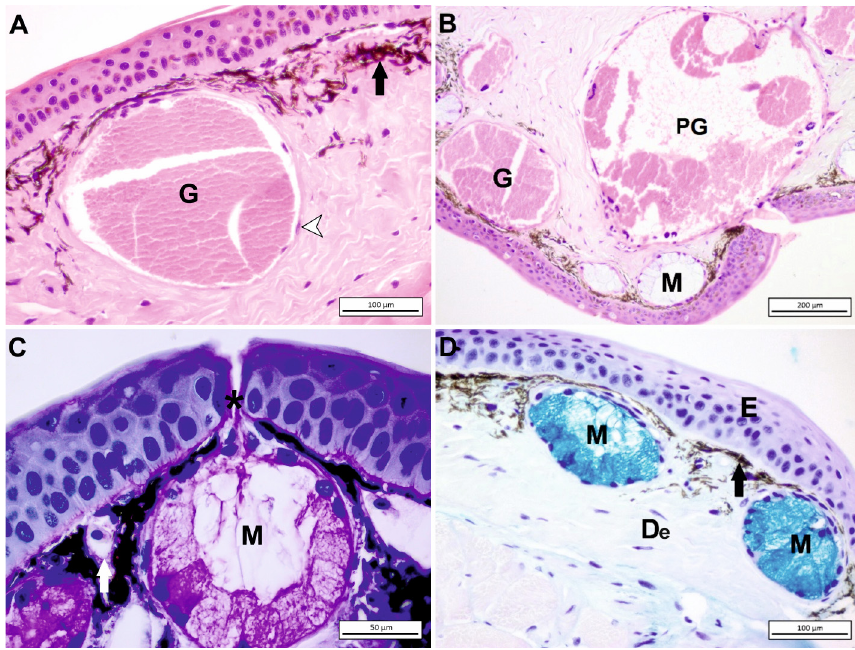
Figure 4. ( A ) The dorsal skin of Salamandra infraimmaculata , granular gland (G), melanophore (black arrow). The periphery of dermal gland was surrounded with a monolayer of myoepithelial cells (arrowhead), Gill’s H&E staining. ( B ) Mucous gland (M), granular gland (G), parotoid gland (PG), H&E staining. ( C ) In the dorsal skin of S. infraimmaculata, each gland discharges secretion by epi- dermal duct (*), mucous gland (M), blood vessel (white arrow) PAS staining. ( D ) The ventral skin of S. infraimmaculata , epidermis (E), dermis (De), mucous gland (M), melanophore (black arrow) AB